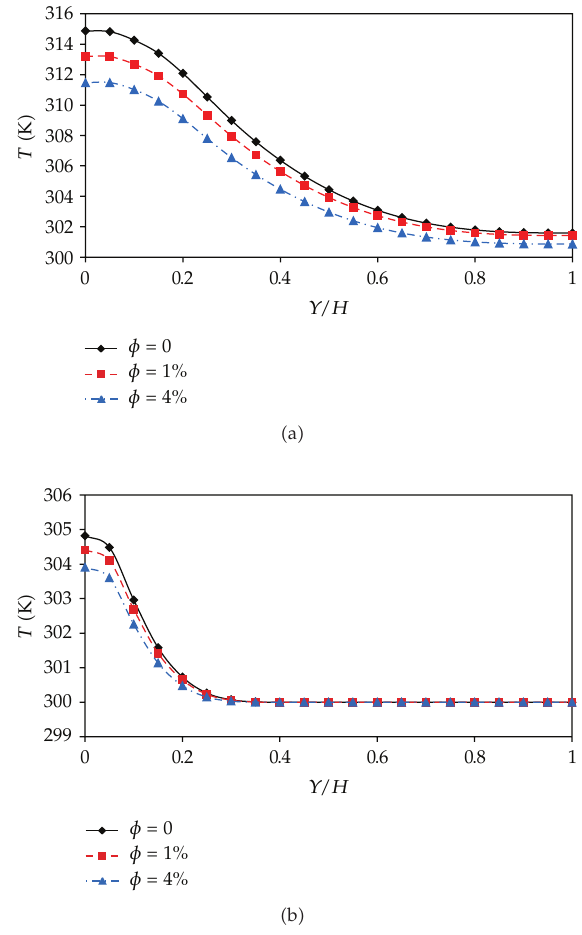
Figure 10: E ff ect of volume fraction φ on temperature profile along channel height at the first of last heat source for: (cid:3) a (cid:5) Re (cid:4) 50, (cid:3) b (cid:5) Re (cid:4)